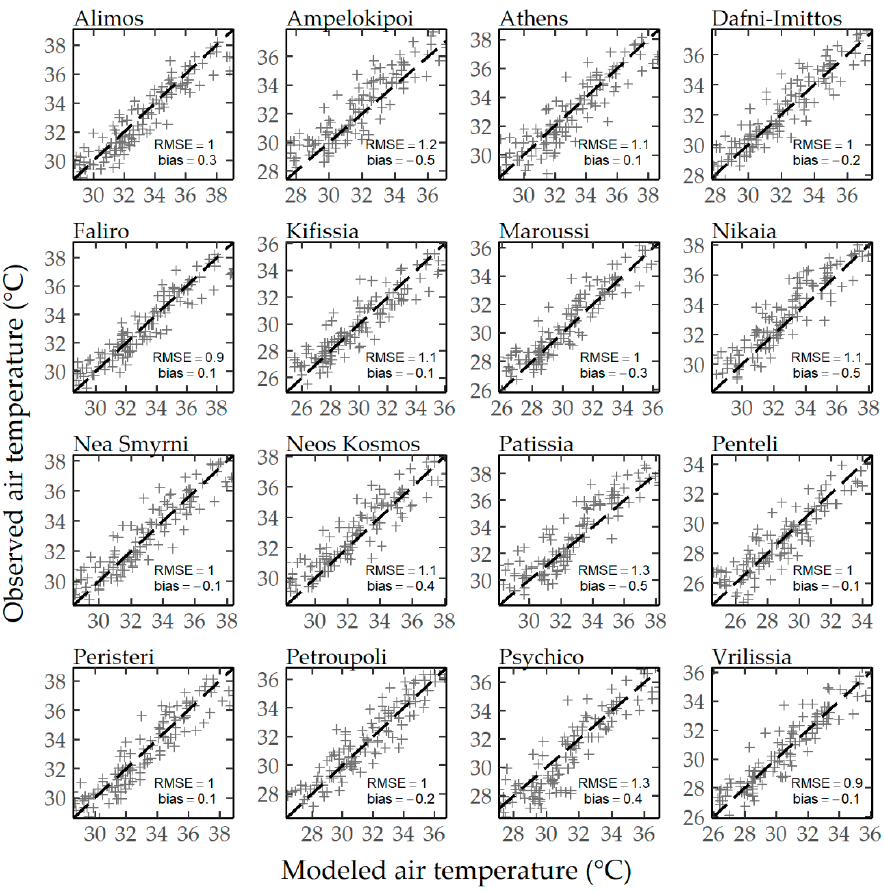
Figure 15. As in Figure 14, for the diagnostic variable T as , urb . Table 11. Average observed and modeled near-surface air temperature for the urban tile of the grid cell ( T as , urb ) in Athens per LCZ (degrees Celsius) (7–11 August 2017).